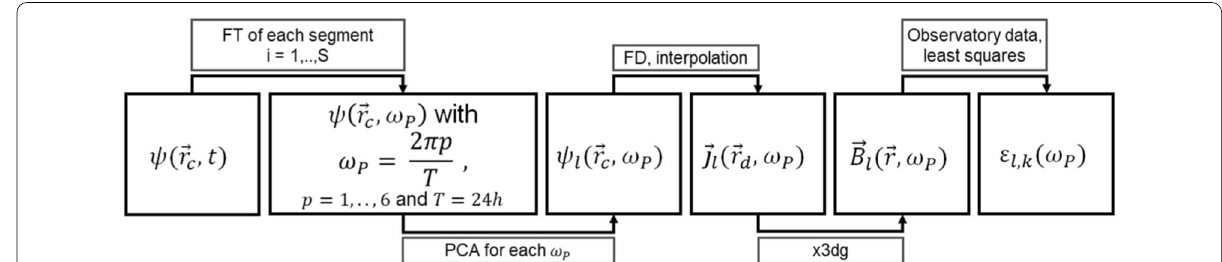
Fig. 3 Workflow used to estimate external source coefficients. FD stands for finite differences. (cid:31) r c and (cid:31) r d denote a “coarse” and “dense” grid, respectively. See details in the